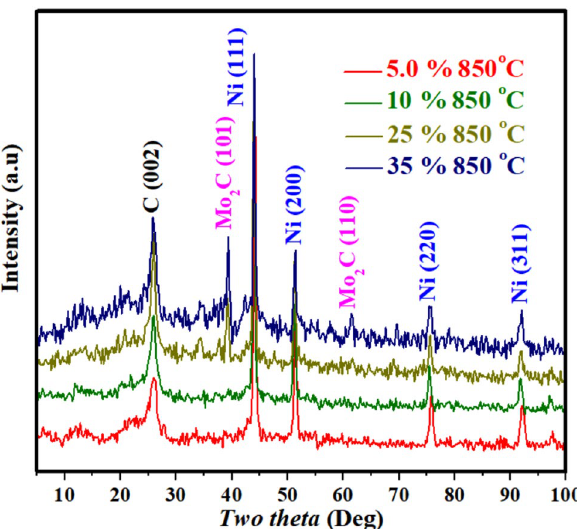
Figure 2. XRD results for the obtained powder after calcination at 850 °C of electrospun nanofiber mats prepared from sol–gel containing different amount of molybdenum precursor